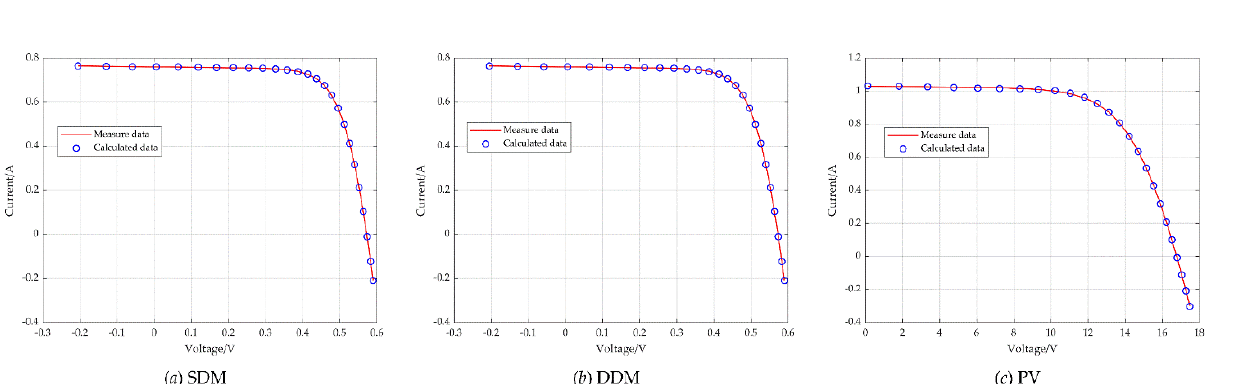
Figure 13. Comparison between measured and simulated data for the three models.